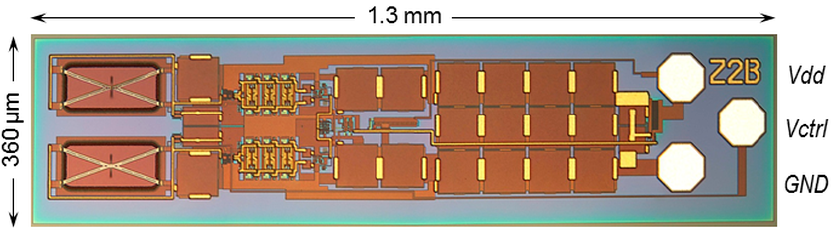
Figure 2. Affinity-viscometric sensor chip with an X-shaped mechanically bendable beam on the left side (bottom: reference; top: measurement) [15].